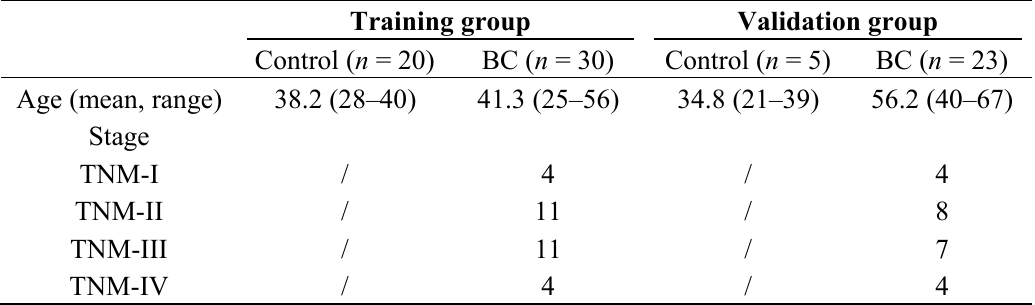
Table 2. Clinical information and characteristics of human subjects. BC, breast